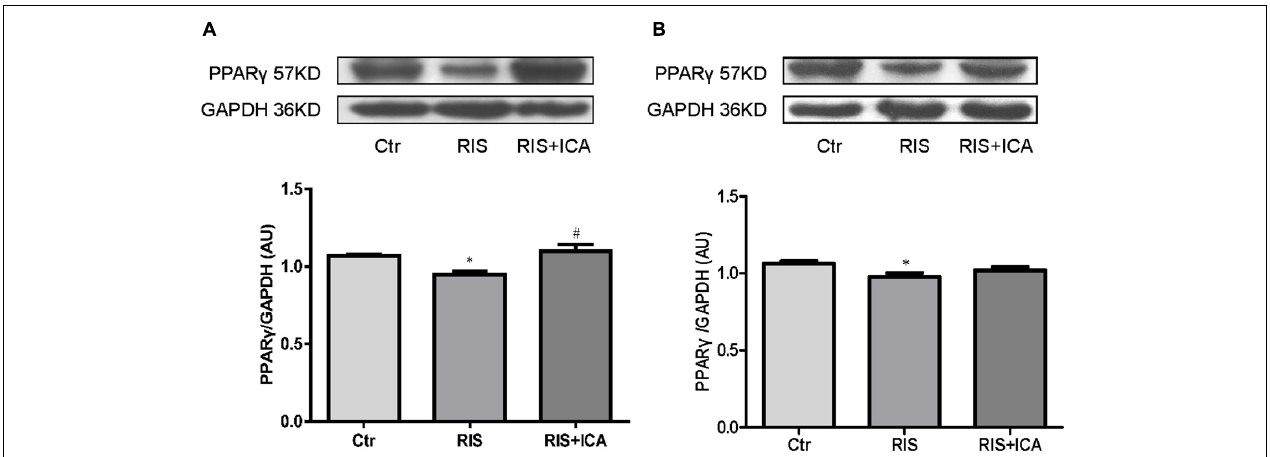
FIGURE 8 | Effect of icariin on PPAR γ in the hippocampus and PFC. (A) PPAR γ expression in the hippocampus using western blotting. The RIS procedure induced a marked decrease in PPAR γ levels in APP/PS1 mice compared with controls, and icariin could reverse the alteration. (B) PPAR γ expression in the PFC using western blotting. The RIS procedure induced a marked decrease in PPAR γ level in APP/PS1 mice compared with controls, and icariin could partially reverse the alteration. The results of hippocampus are expressed as the mean ± SEM, n = 4; the results of PFC are expressed as the mean ± SEM, n = 5. ∗ p < 0.05 vs. control group; # p < 0.05 vs. RIS